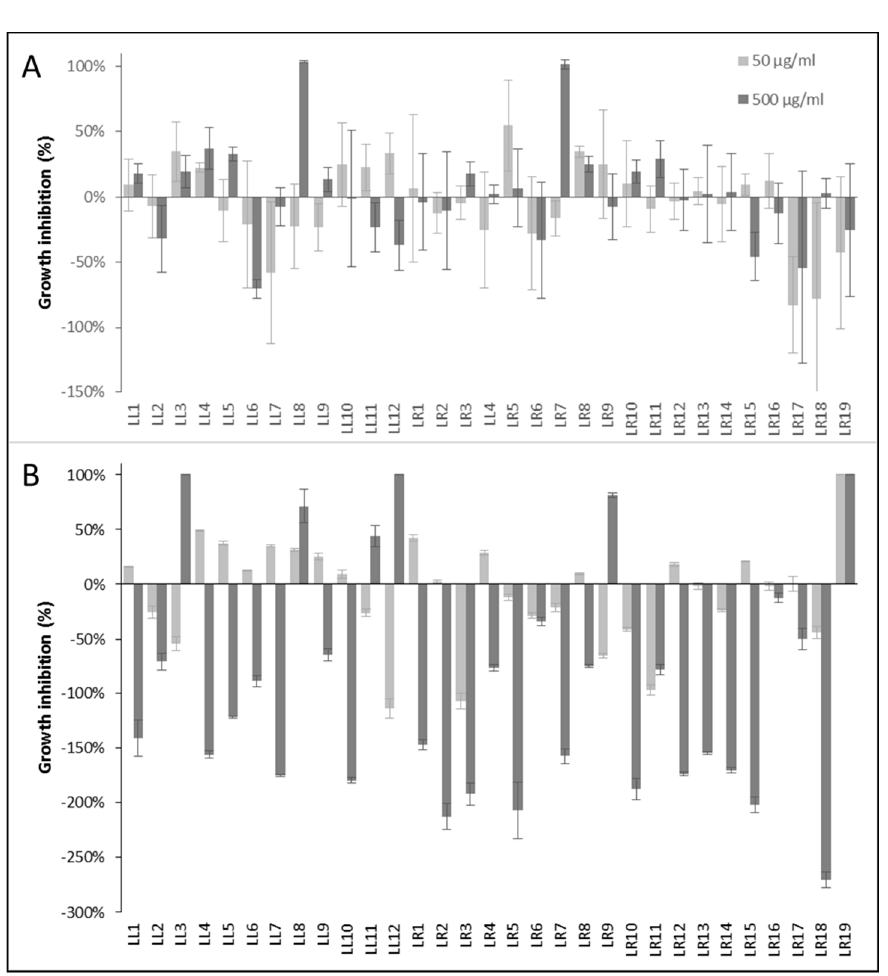
Figure 5. Antibacterial activity of Lumnitzera littorea and L. racemosa extracts against ( A ) Gram- positive Bacillus subtilis and ( B ) Gram-negative Aliivibrio fischeri. Chloramphenicol (100 µM) was used as positive control and induced the complete inhibition of bacterial growth. Negative values indicate growth enhancement.